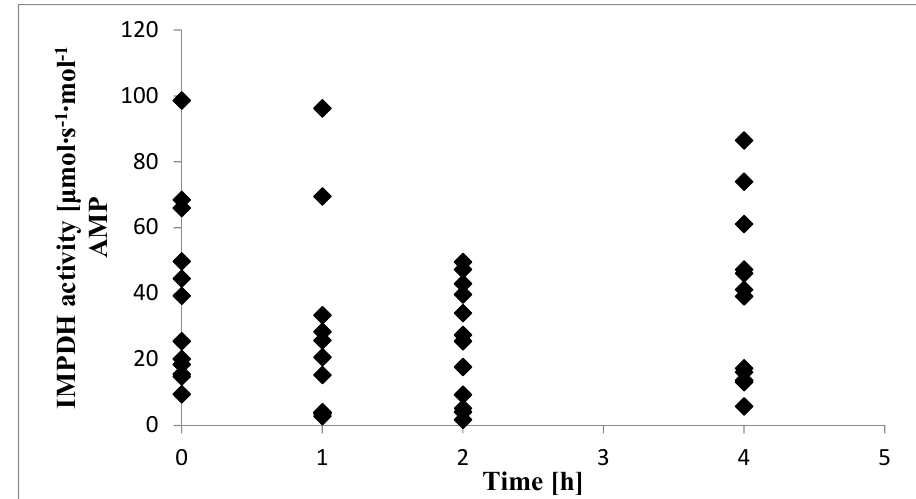
Figure 3. The individual values of inosine 5 (cid:48) -monophosphate dehydrogenase (IMPDH) activity in relation to time elapsed after mycophenolate mofetil (MMF) administration in 12 children with nephrotic